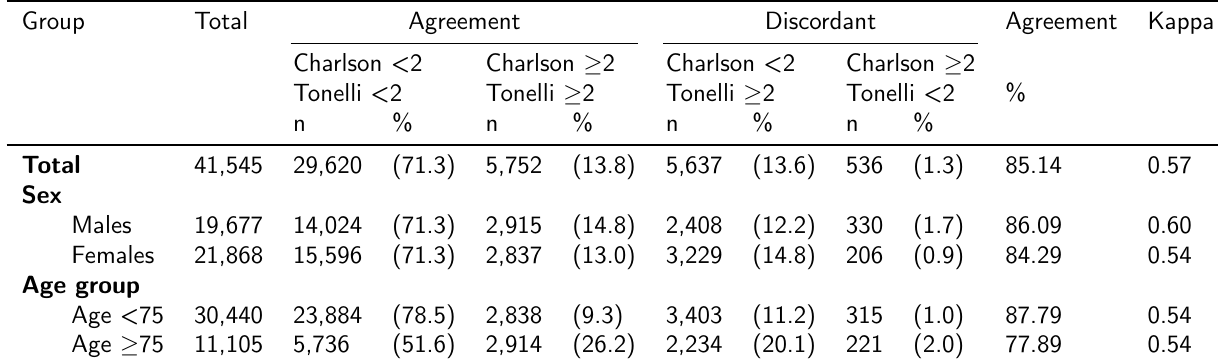
Table 2: Agreement between Tonelli and Charlson